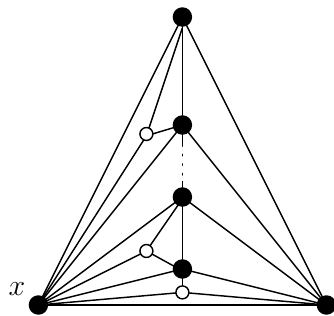
Figure 11: A triangulation H with domination number 1 but high facial achromatic